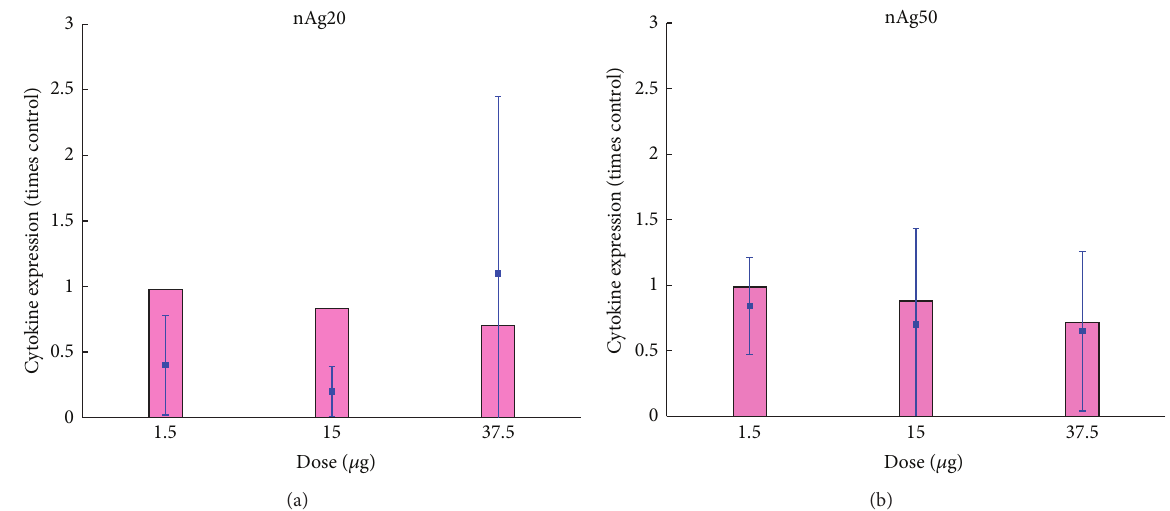
Figure 8: Comparison of model predictions and measured values of anti-inflammatory cytokine (IL-10) levels in culture medium after 4 hours for human MDMs with different doses of 20nm (a) and 50 nm (b) nAg in vitro . Bars represent model predictions and squares and error bars represent in vitro